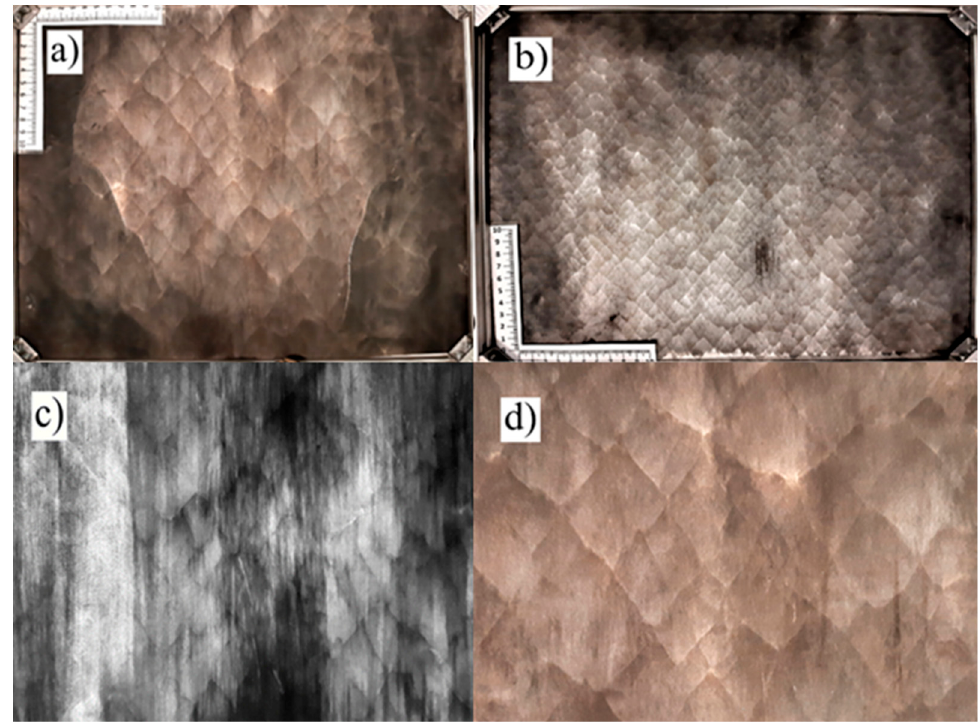
Figure 4. Examples of recorded cellular structure: ( a ) low pressure, big cells; ( b ) high pressure, small cells; ( c ) partially blown out soot; ( d ) unstable cellular structure.